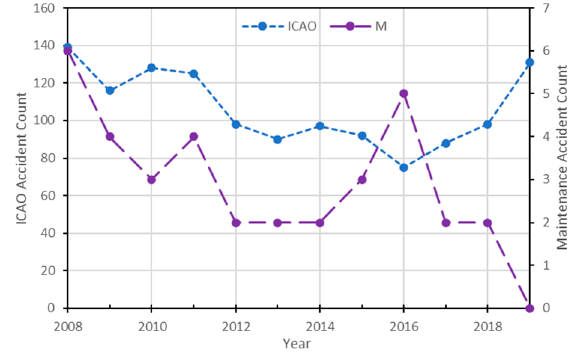
Figure 11. The trends over time for accidents with maintenance contributions (secondary axis, purple line with large dashes) and all ICAO official accident (blue line with small dashes).